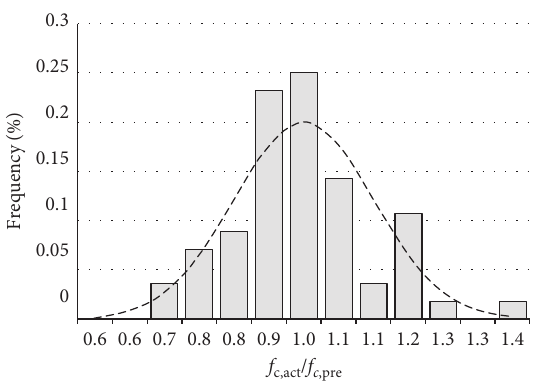
Figure 9: Frequency distribution of the actual/predicted values of the geopolymer’s cylindrical compressive